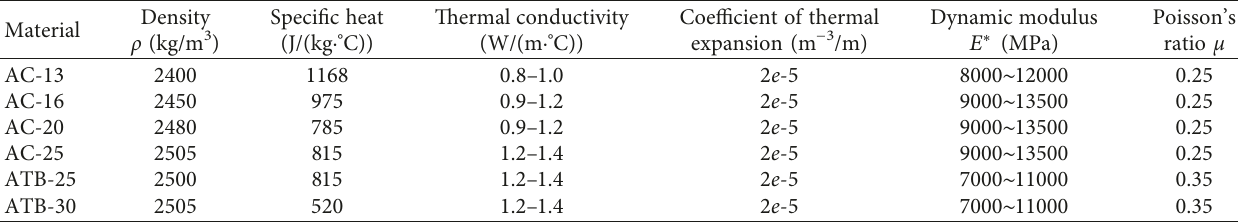
Table 5: Thermophysical and mechanical parameters of asphalt mixtures.